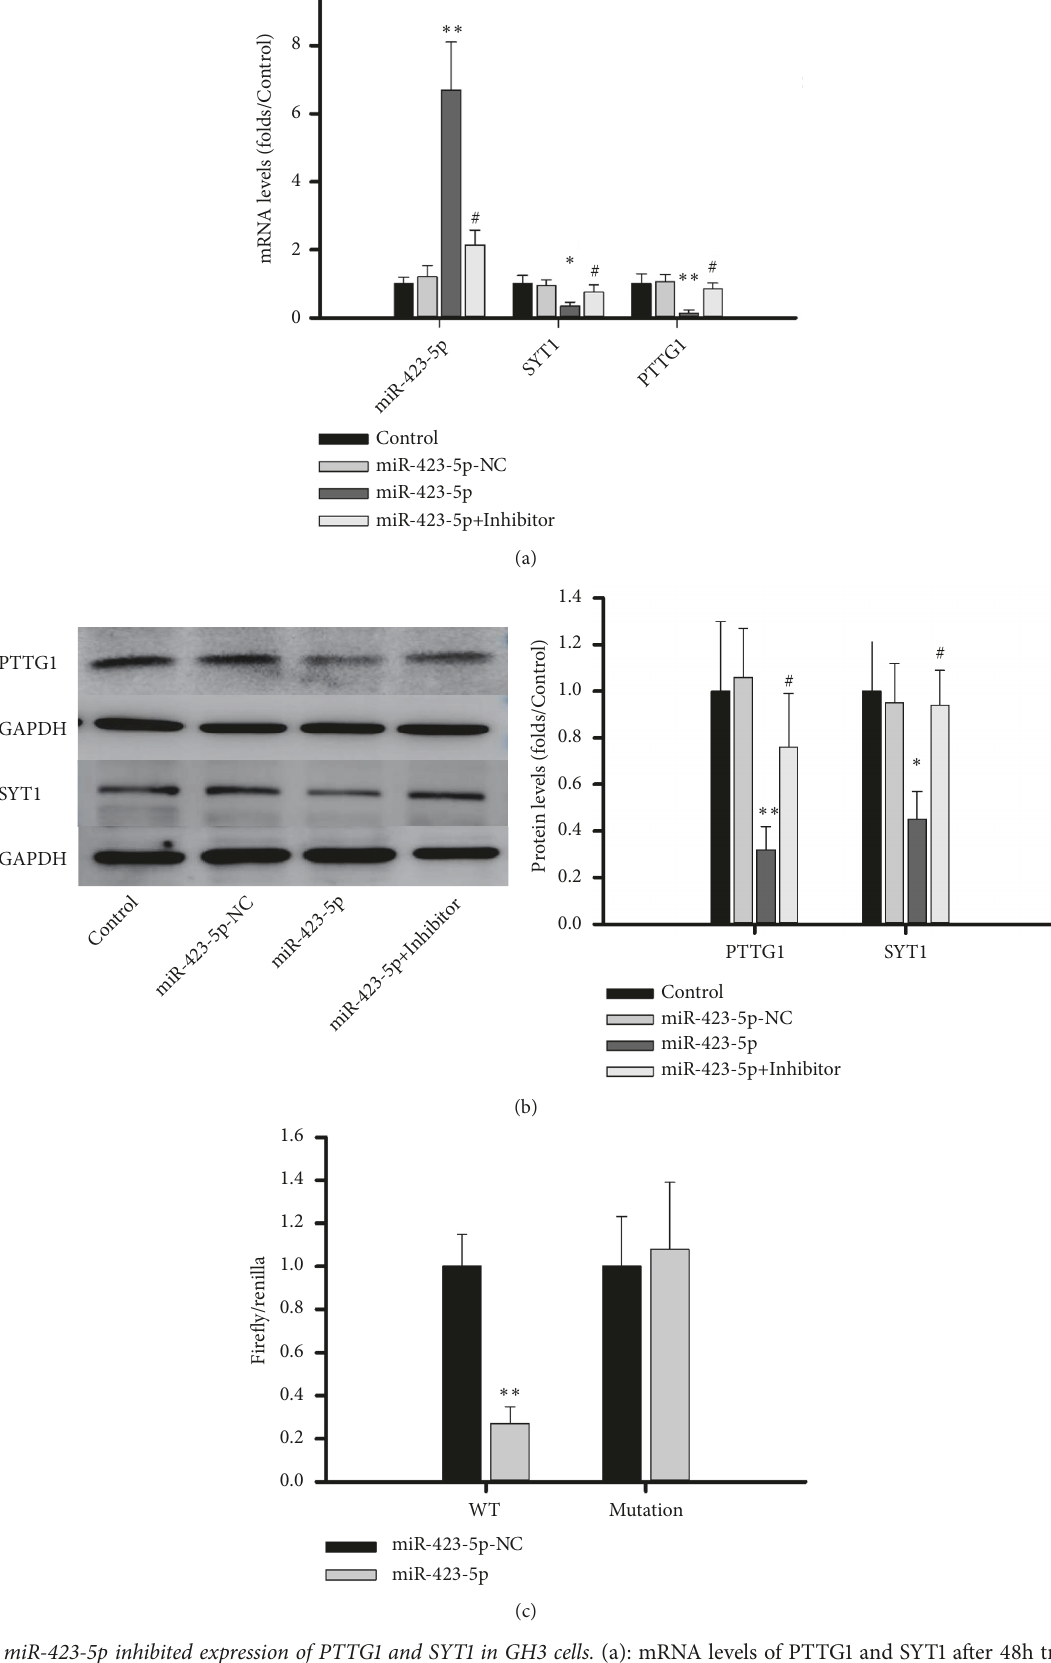
Figure 4: miR-423-5p inhibited expression of PTTG1 and SYT1 in GH3 cells. (a): mRNA levels of PTTG1 and SYT1 after 48h transfection. (b): Protein levels of PTTG1 and SYT1 after 48h transfection. (c): The activity of firefly/renilla after 48h transfection of PTTG1 wild-type or mutation plasmid. ∗ compared to control group ∗ p < 0.05 ∗∗ p < 0.01, #compared to miR-423-5p, p < 0.05, n =